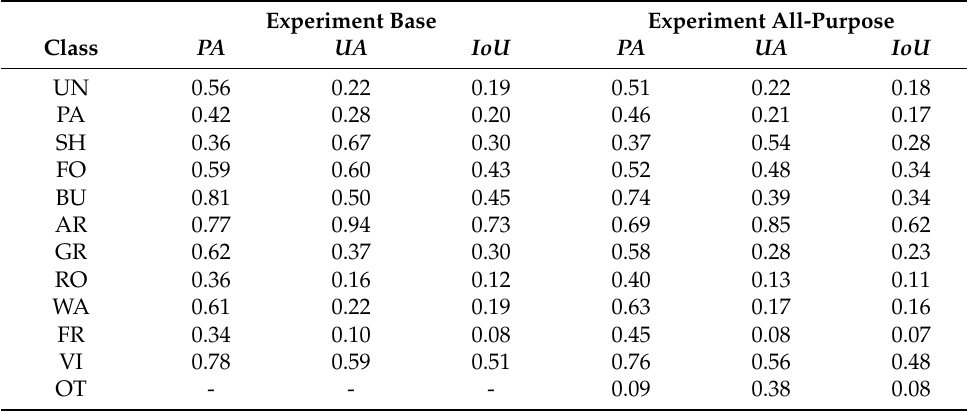
Table 17. Class metrics for the experiment with UNet on UOS2. Experiment Base Experiment